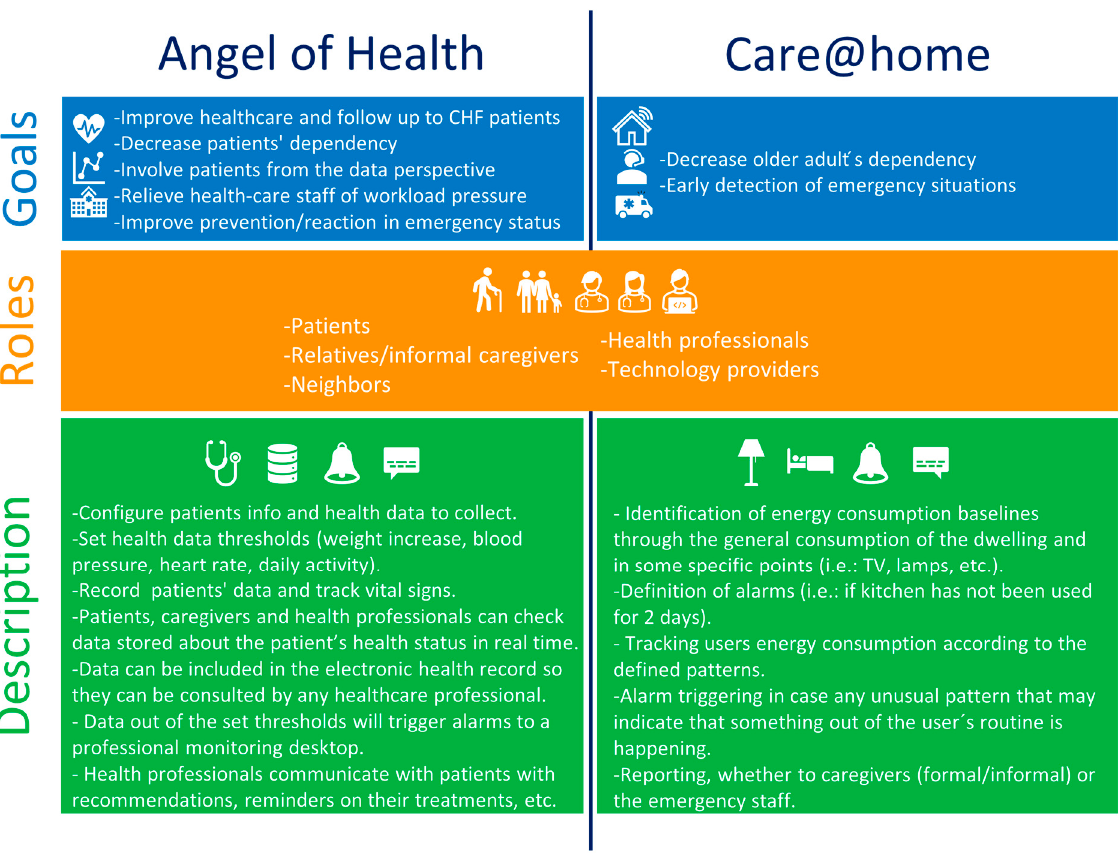
Figure 1. Scenarios of the Pharaon Murcia pilot.